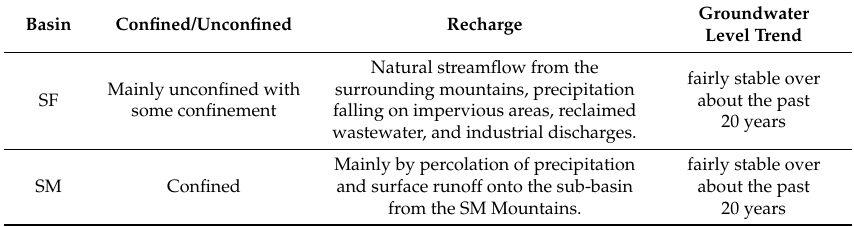
Table 4. Overall characteristics of San Fernando (SF) and Santa Monica (SM) basins [74,75].